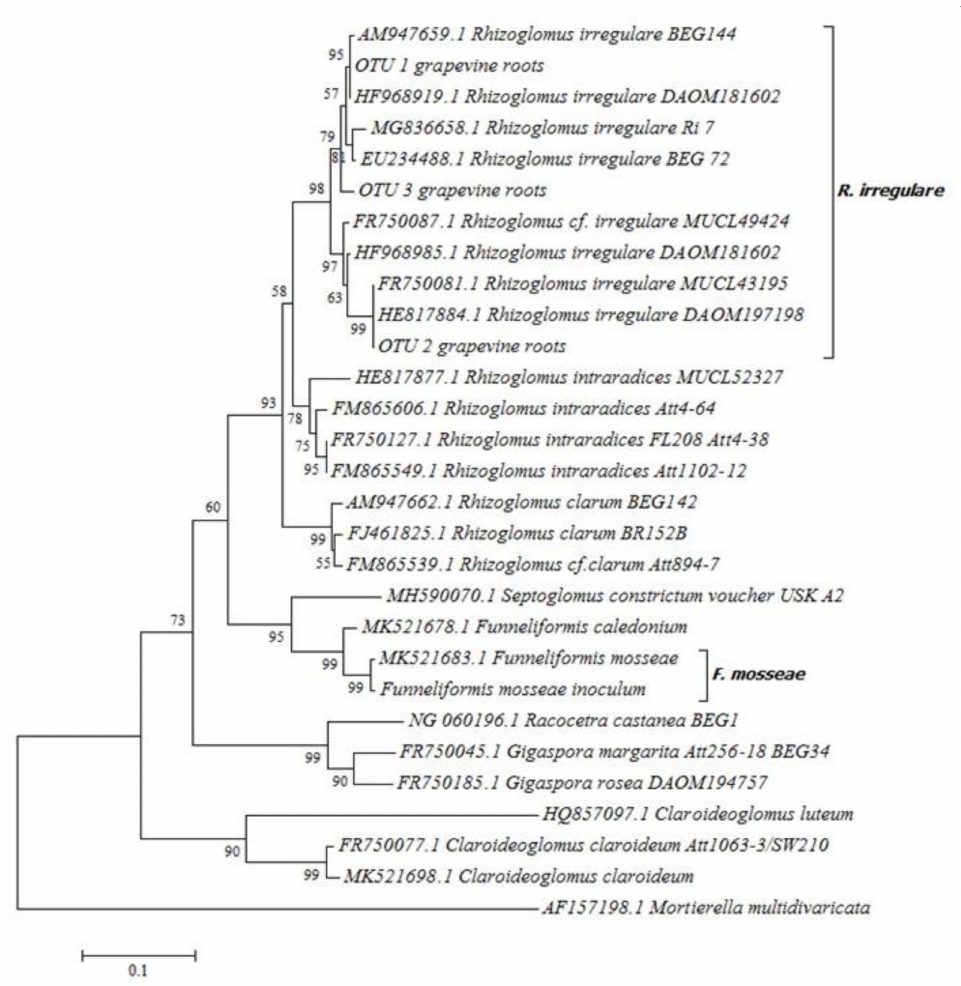
Figure 1. Neighbor-joining tree of nuclear large subunit (LSU) ribosomal RNA gene sequence. The tree shows the phylogenetic relationships among the tree operational taxonomic units (OTUs) identified in original grapevine root samples proceeding from the nursery, the two arbuscular mycorrhizal fungi (AMF) present in the inocula used in the experiment, and other representative species and isolates of Glomeromycota phylum. The optimal tree with the sum of branch length = 1.93277612 is shown. The percentage of replicate trees in which the associated taxa clustered together in the bootstrap test (1000 replicates) are shown next to the branches [65]. The tree is drawn to scale, with branch lengths in the same units as those of the evolutionary distances used to infer the phylogenetic tree. The evolutionary distances were computed using the Tamura–Nei method [66] and are in the units of the number of base substitutions per site. All positions containing gaps and missing data were eliminated. Evolutionary analyses were conducted in MEGA7 [67]. Taxon names used in the neighbor-joining tree were adapted according to the latest nomenclature of AMF published at